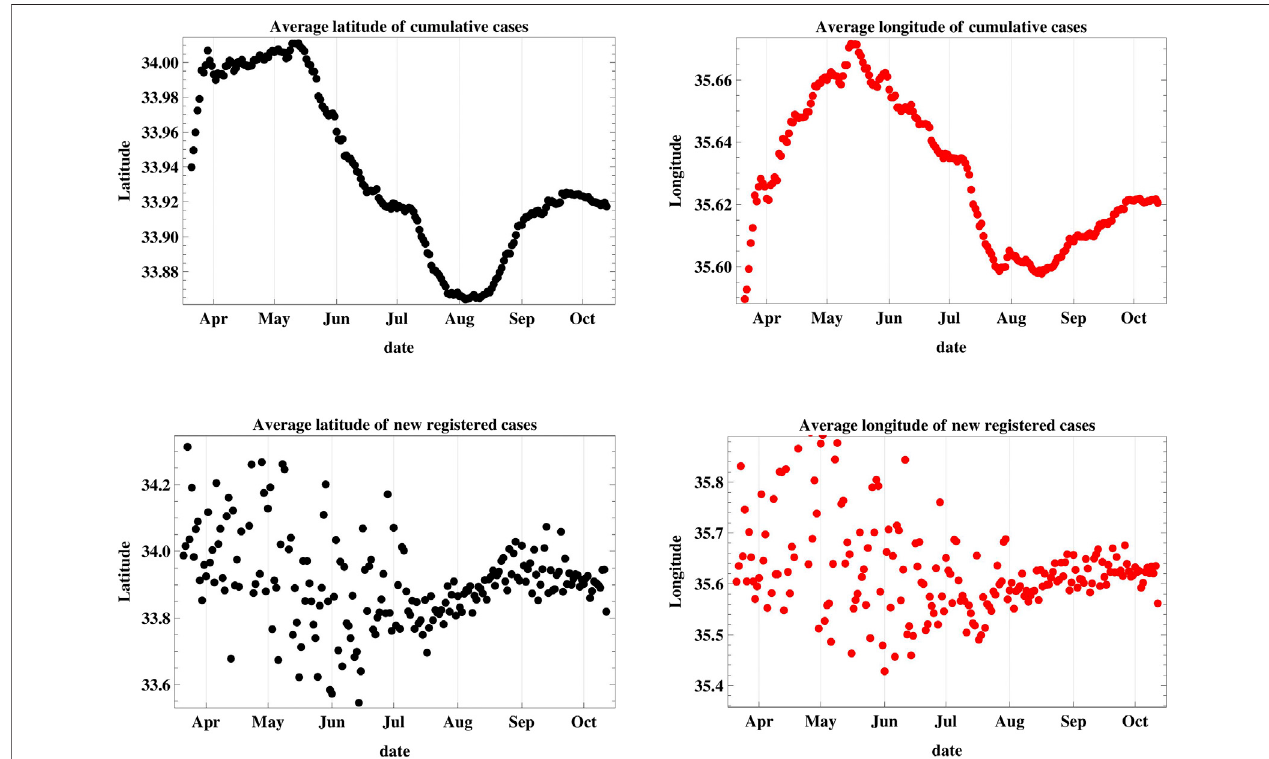
FIGURE5| This fi gureisaplotofthelatitudeandlongitudeoftheweightedgeographiccenterofCOVID-19infectionsinLebanon.Theuppergraphsrepresent the temporal progression of the cumulative number of infections while the lower graphs represent that of the new daily cases.